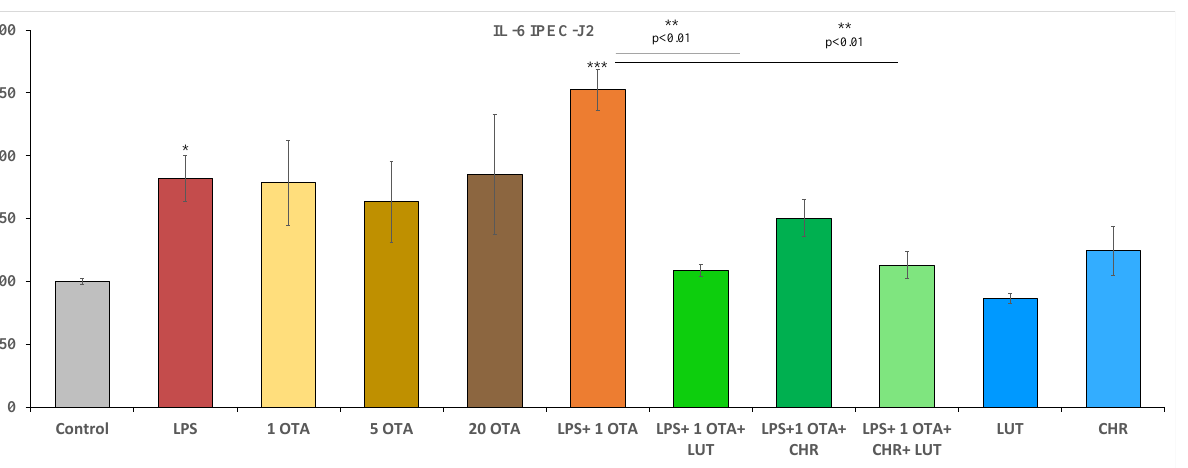
Figure 5. Relative fluorescence intensity in control% using DCFH-DA method. Measurement of IC ROS levels after 24 h treatment of IPEC-J2 cells with 1 µ M OTA, 5 µ M OTA, 20 µ M OTA, 1 µ M CHR, 8.7 µ M LUT, 10 µ g/mL LPS and their combinations; data are shown as means of relative fluorescence intensities with SEM; n = 3 samples per group, * indicates p < 0.05, ** indicates p < 0.01, *** indicates p < 0.001; λ exc = 480 nm, λ em = 530 nm. Asterisks alone indicate significant differences between control and treated groups, asterisks with p values underlined show significant changes between the designated groups.